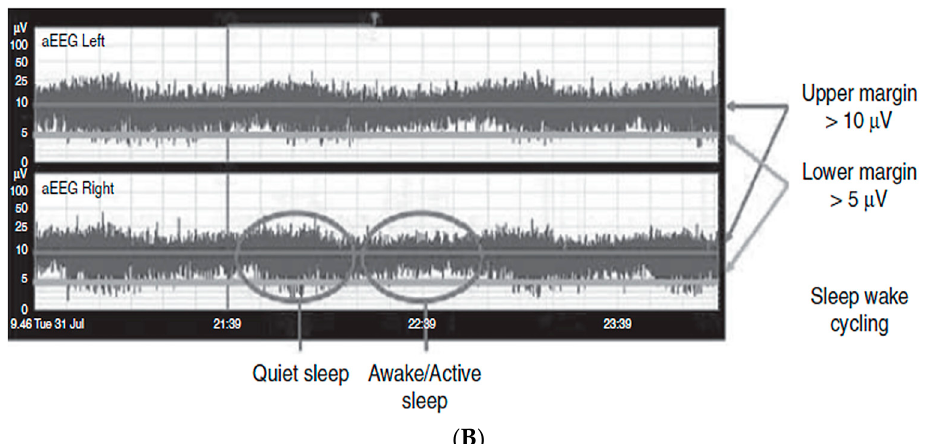
Figure 2. Trace alternant in a term baby ( A ) and sleep-wake cycling in an amplitude integrated EEG (aEEG) ( B ). Note the alternating background in ( A ). ( B ) demonstrates expansion of the background pattern during quiet sleep and narrowing during awake/active sleep. Quiet sleep on the aEEG is the equivalent of trace alternant on the EEG. Figures are derived from [32,38].